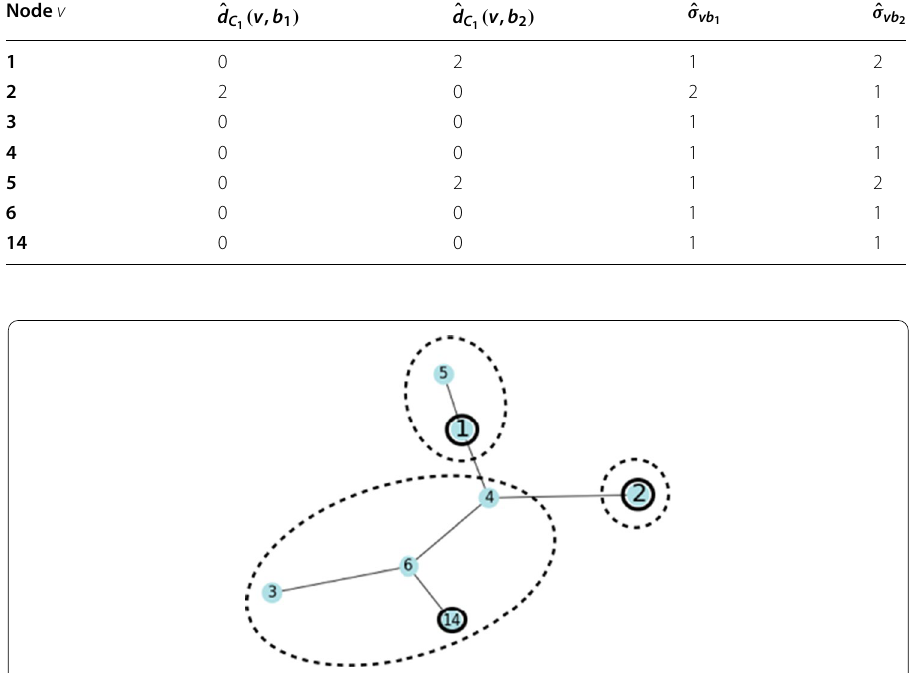
Fig. 2 Classes of equivalent nodes in the blue cluster C